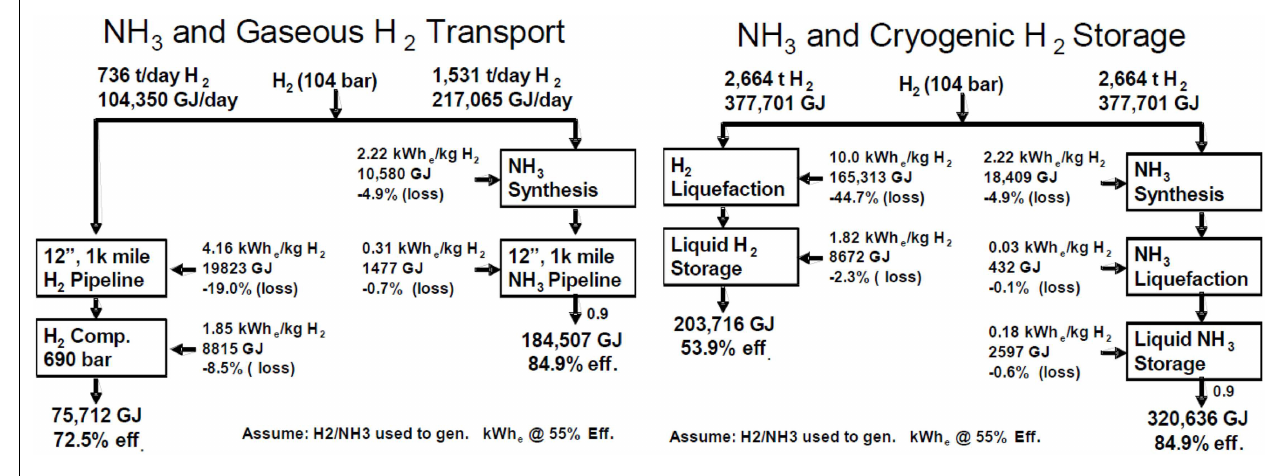
FIGURE 1 | Comparison of energy efficiency on transport of H 2 and NH 3 at gaseous or liquid state (Olson and Holbrook, 2007) .